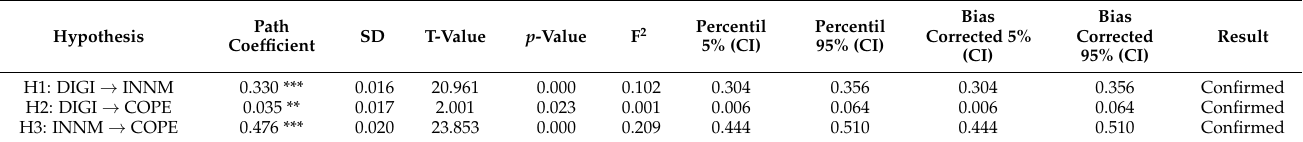
Table 6. Model Hypothesis